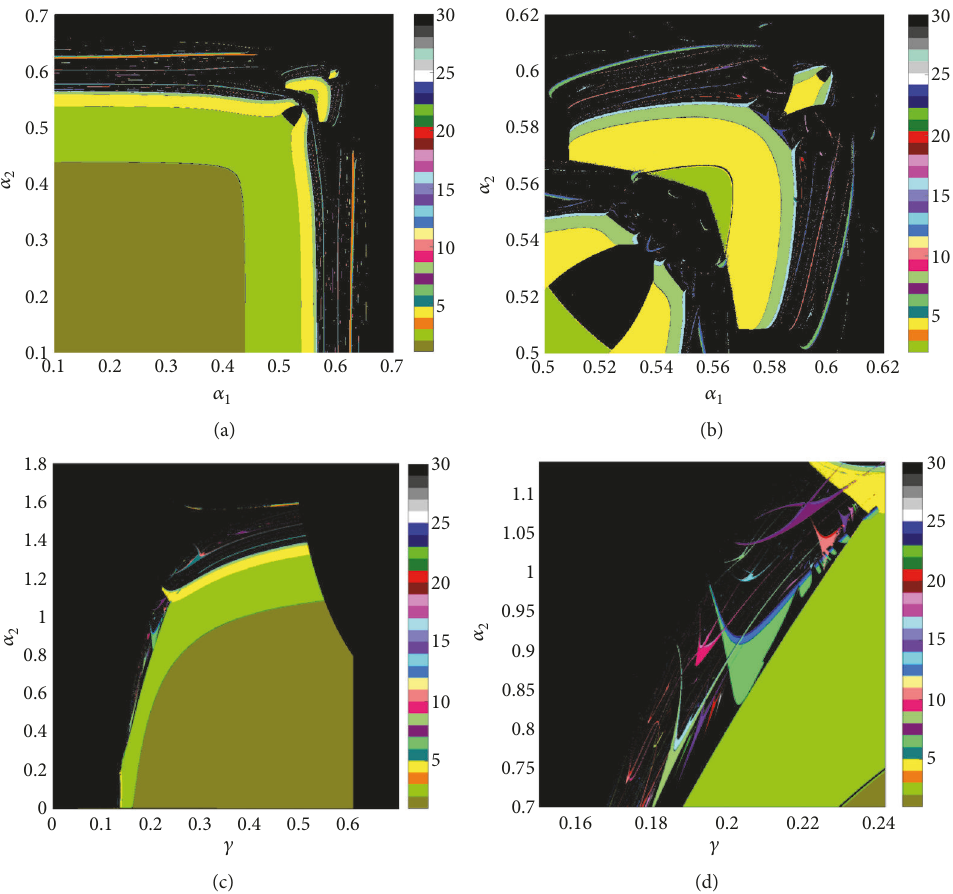
Figure 3: (a) The two-parameter bifurcation diagram in the parameter plane (𝛼 1 ,𝛼 2 ) with fixed parameters as 𝑎 = 7.12 , 𝑏 = 0.024 , 𝑐 = 0.98 , 𝛽 = 0.38 , and 𝛾 = 0.44 . (b) Partial enlargement of (a). (c) The two-parameter bifurcation diagram in the parameter plane (𝛾, 𝛼 parameters as 𝑎 = 2.679 , 𝑏 = 0.061 , 𝑐 = 0.105 , 𝛼 1 = 0.666 , and 𝛽 = 0.375 . (d) Partial enlargement of